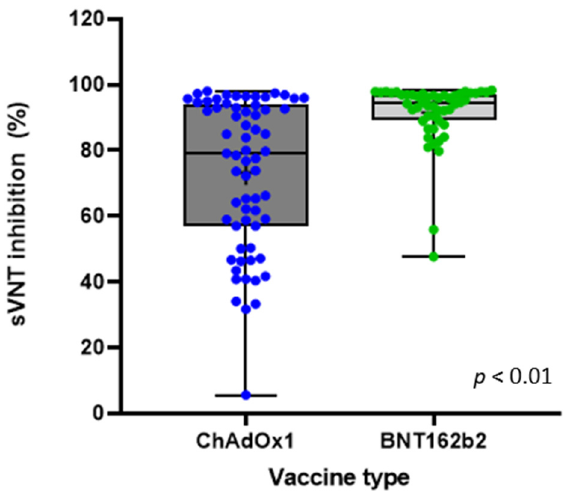
Figure 1. Neutralizing antibody level measured by percentage inhibition of sVNT readings in both vaccine